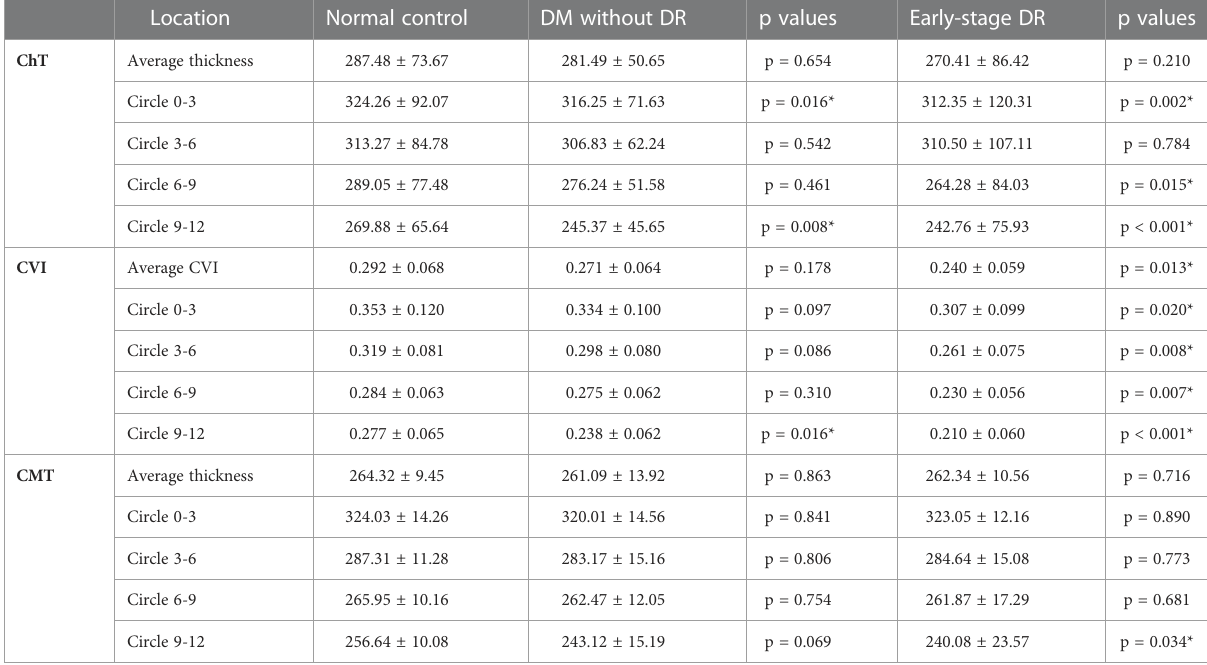
TABLE 3 Optical coherence tomographical fi ndings in patients with early-stage diabetic retinopathy, diabetes mellitus without DR and normal control group.